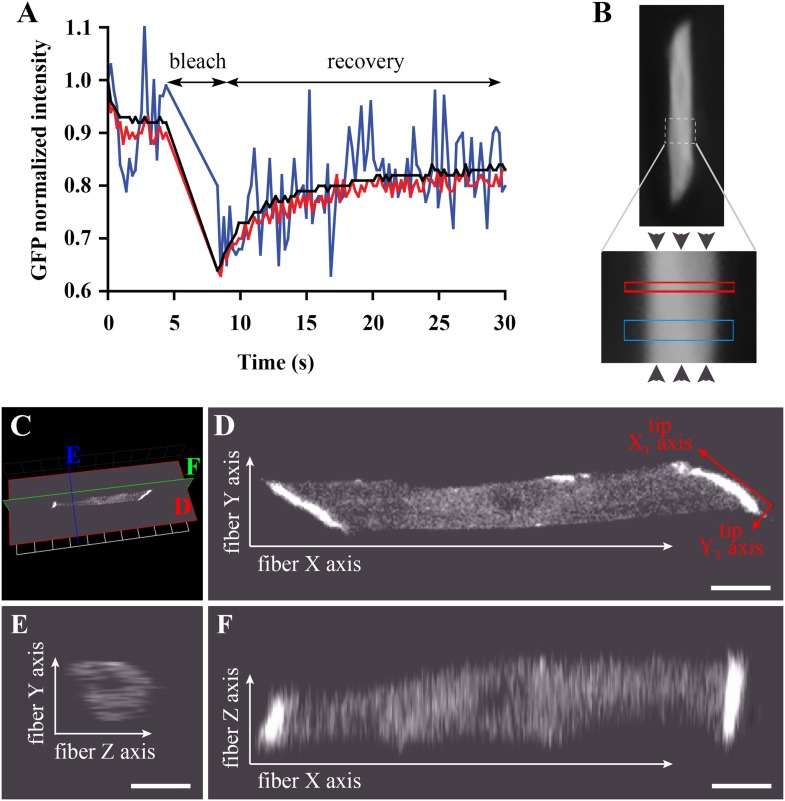
Bleaching areas: size optimization, orientation, and definition of Cartesian coordinates.(A) Noise reduction in GFP FRAP curve for increasing areas: 1 (blue), 25 (red) and 256 (black) pixels. (B) To determine D along the X-axis (arrowheads) of individual muscle cells in the embryo, two large regions of different widths (narrow and wide; see Table 1) are bleached sequentially and separated by >1 min to ensure full recovery. (C) XYZ view from Volocity of a typical muscle fibre expressing huDysGFP in vivo. The cut planes shown correspond to panels D–F. (D) Muscle fibre imaged in the XY plane from a lateral position of the zebrafish embryo as embedded for FRAP. When referring to the fibre tips, we use a different set of axes: the long axis of the tip is the XT axis and the shorter is the YT axis. (E, F) YZ and XZ sections, respectively, through the muscle fibre, showing lower Z resolution. Scale bars = 10 µm.